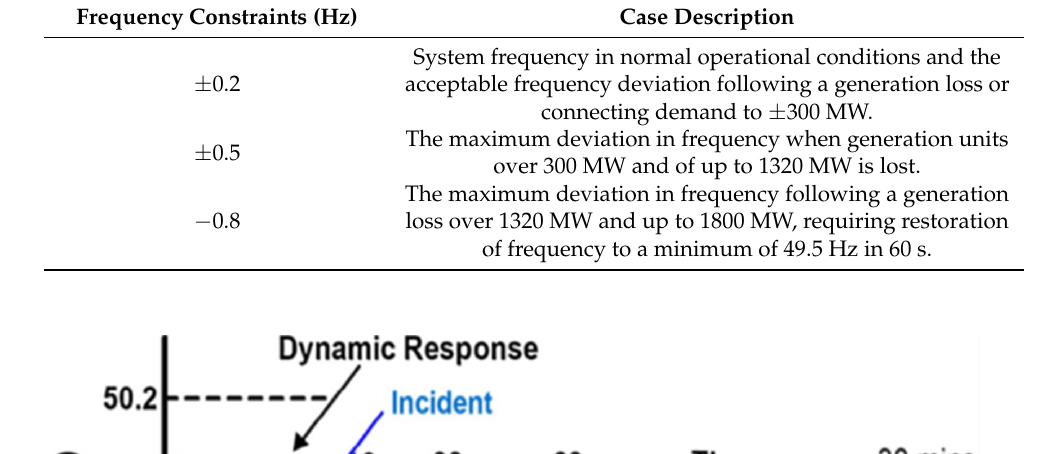
Table 1. Frequency limits for the GB power system.